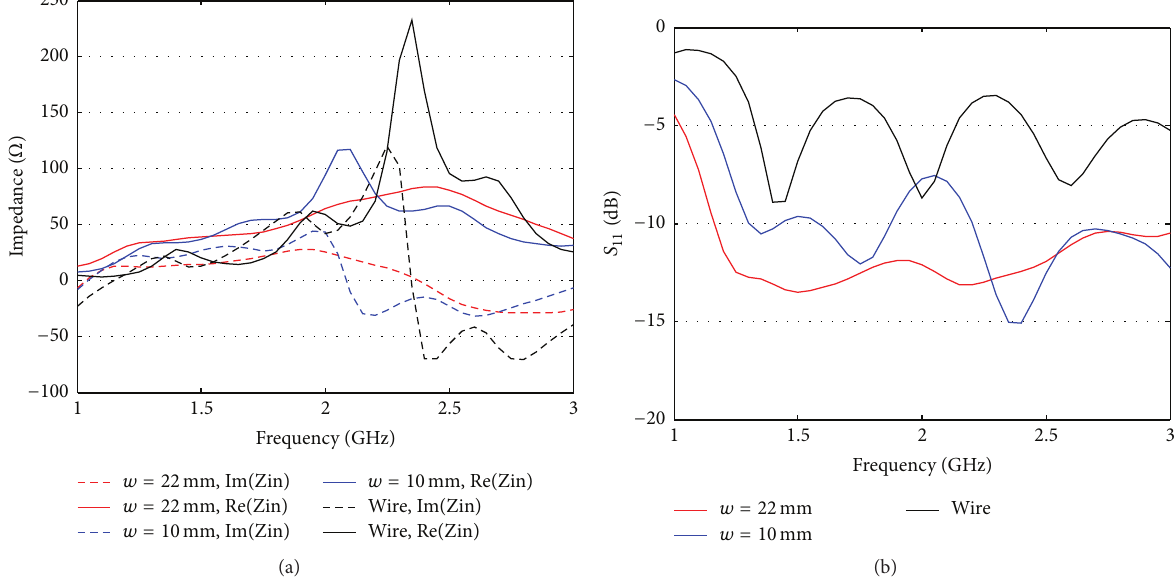
Figure 4: Input impedance and reflection coefficient ( 𝑆 11 ) against frequency when the helix is made of strips and wire. (a) Input impedance. (b) 𝑆 11 .